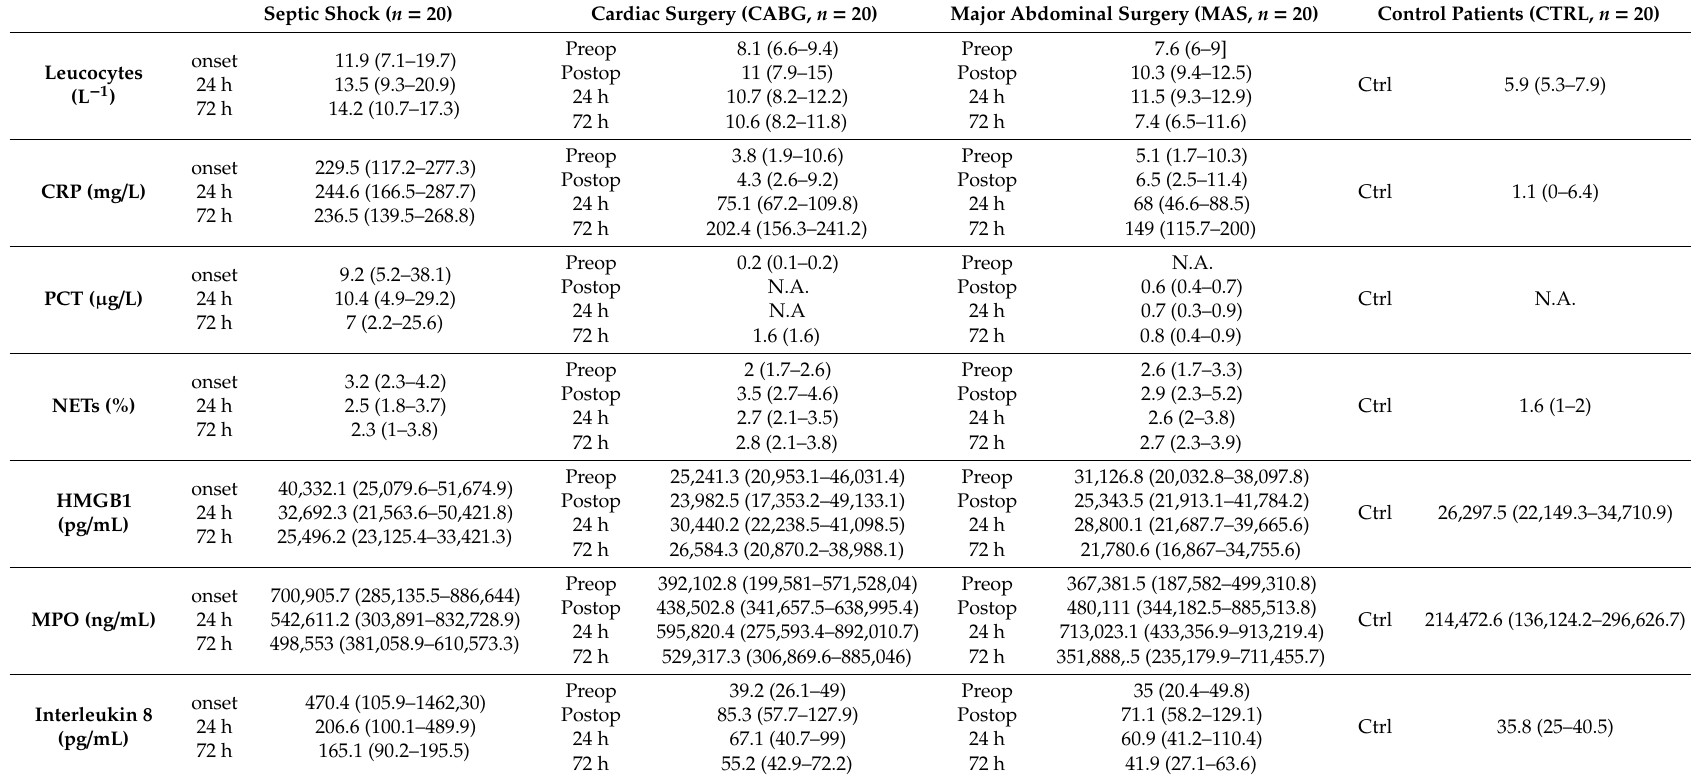
Table 2. Results of inflammatory